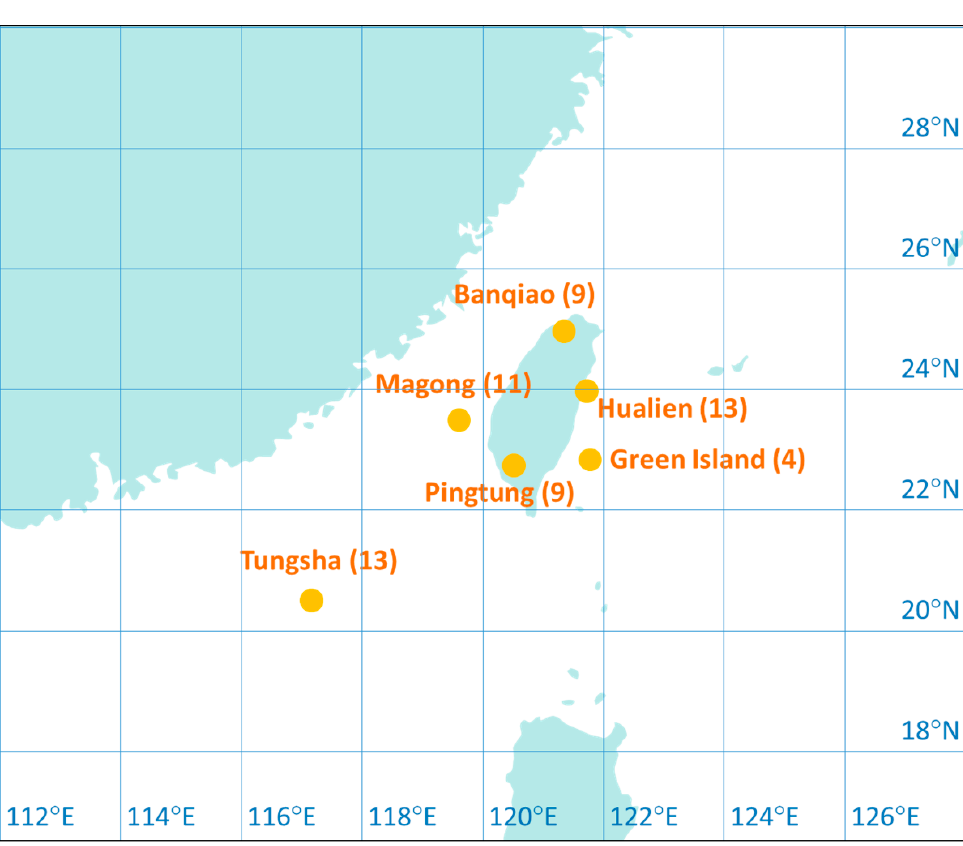
Figure 2. The distribution of the 59 sampled pairs of COSMIC-2/FORMOSAT-7 RO and radiosonde profiles.